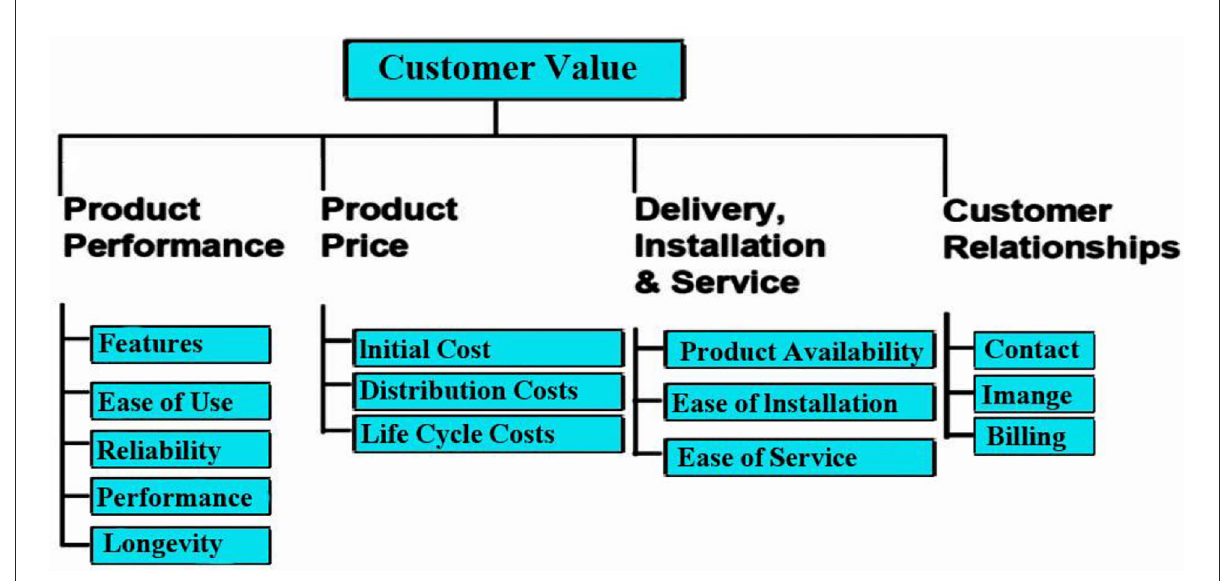
FIGURE10 Customer value tree.